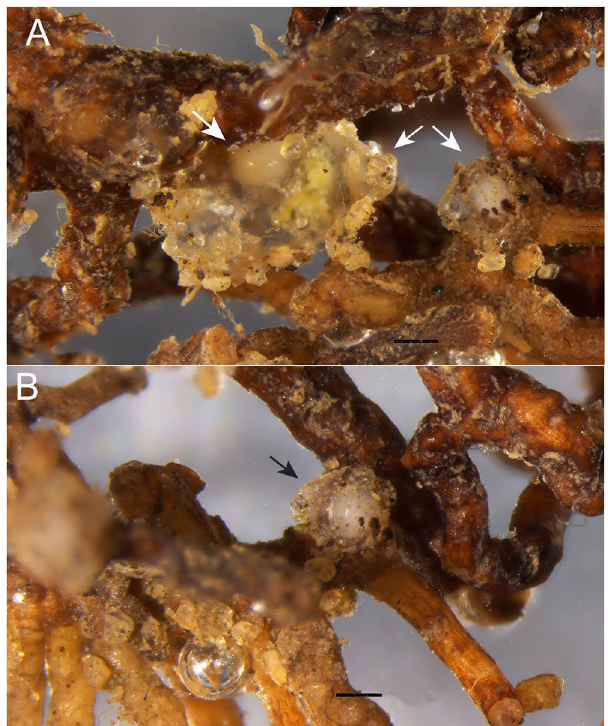
Figure 1. ( A,B ) Infected roots of grape with females protruding (arrows), some cover by a massive eggs mass. (Scale bars: 0.5